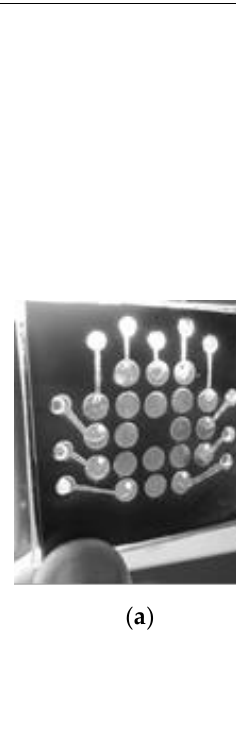
Figure 4. Sample capillary chips for LLS measurements: capillary (H × W × L) 0.1 mm × 1 mm × 10 mm ( a ); 0.08 mm × 0.7 mm × 30 mm ( b ); and 0.08 mm × 1.5 mm × 30 mm ( c ).